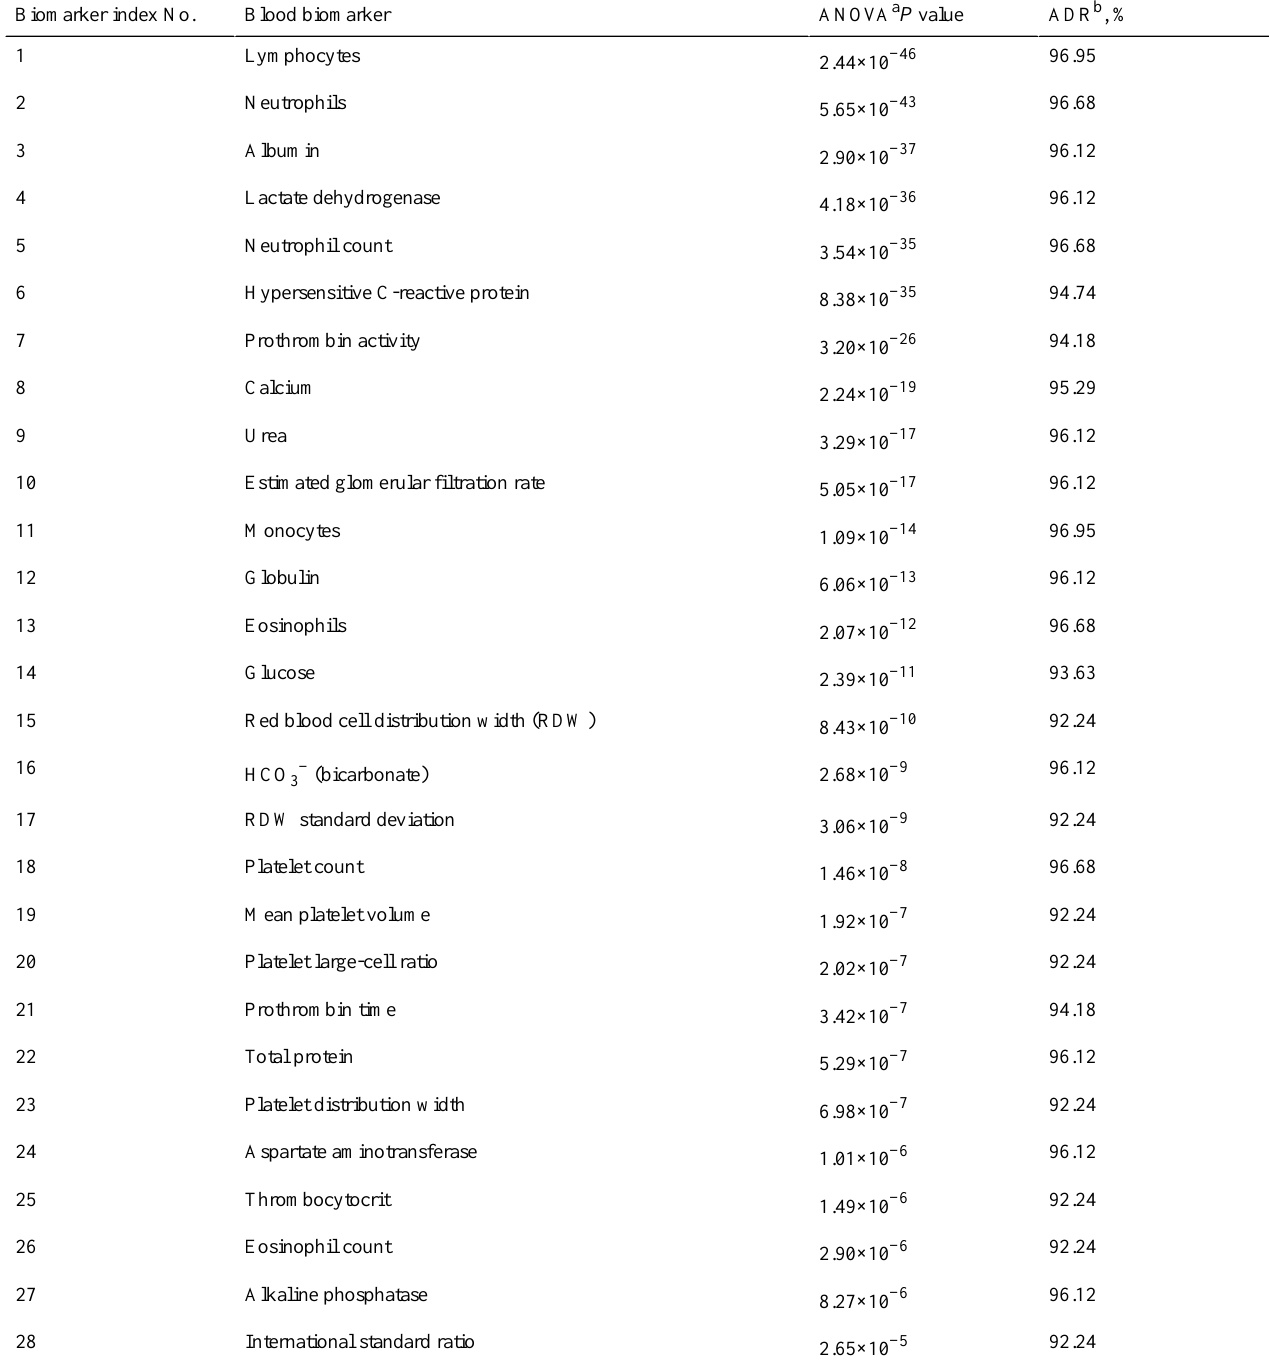
Table 2. List of 28 blood biomarkers selected for the artificial intelligence model